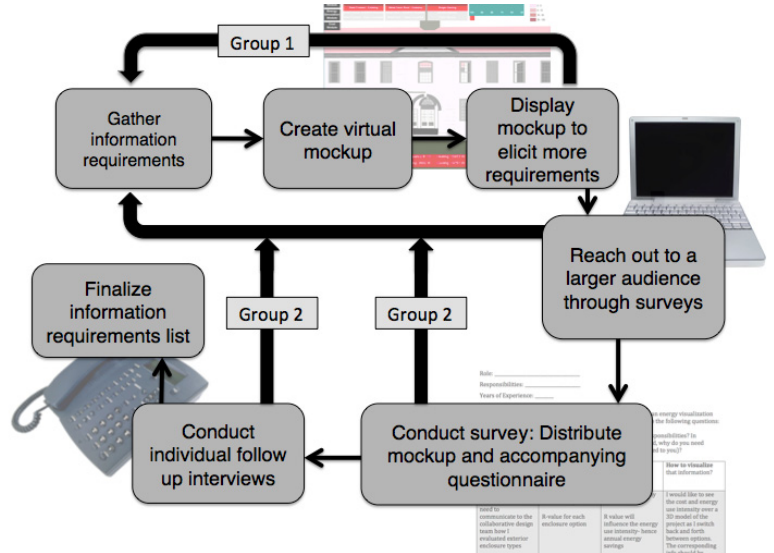
Figure 1. Steps of the iterative requirements elicitation process.